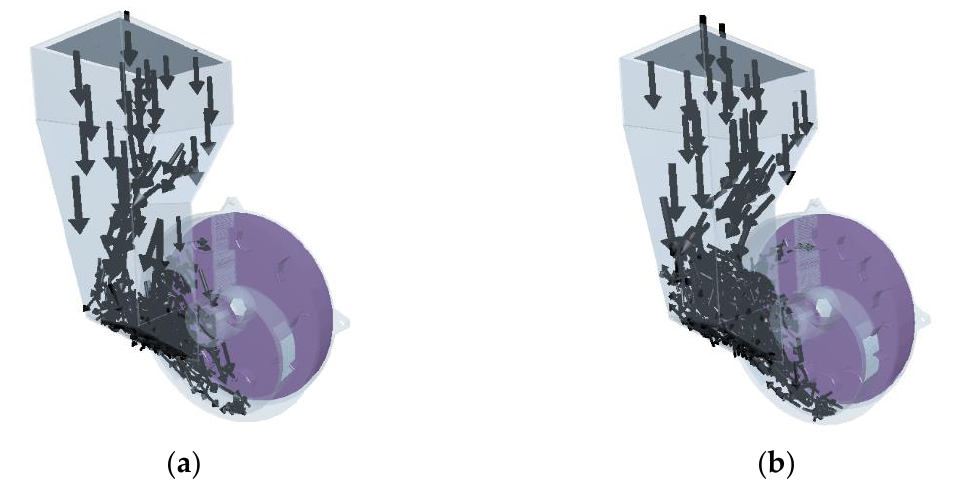
The Number of Teeth Is 12